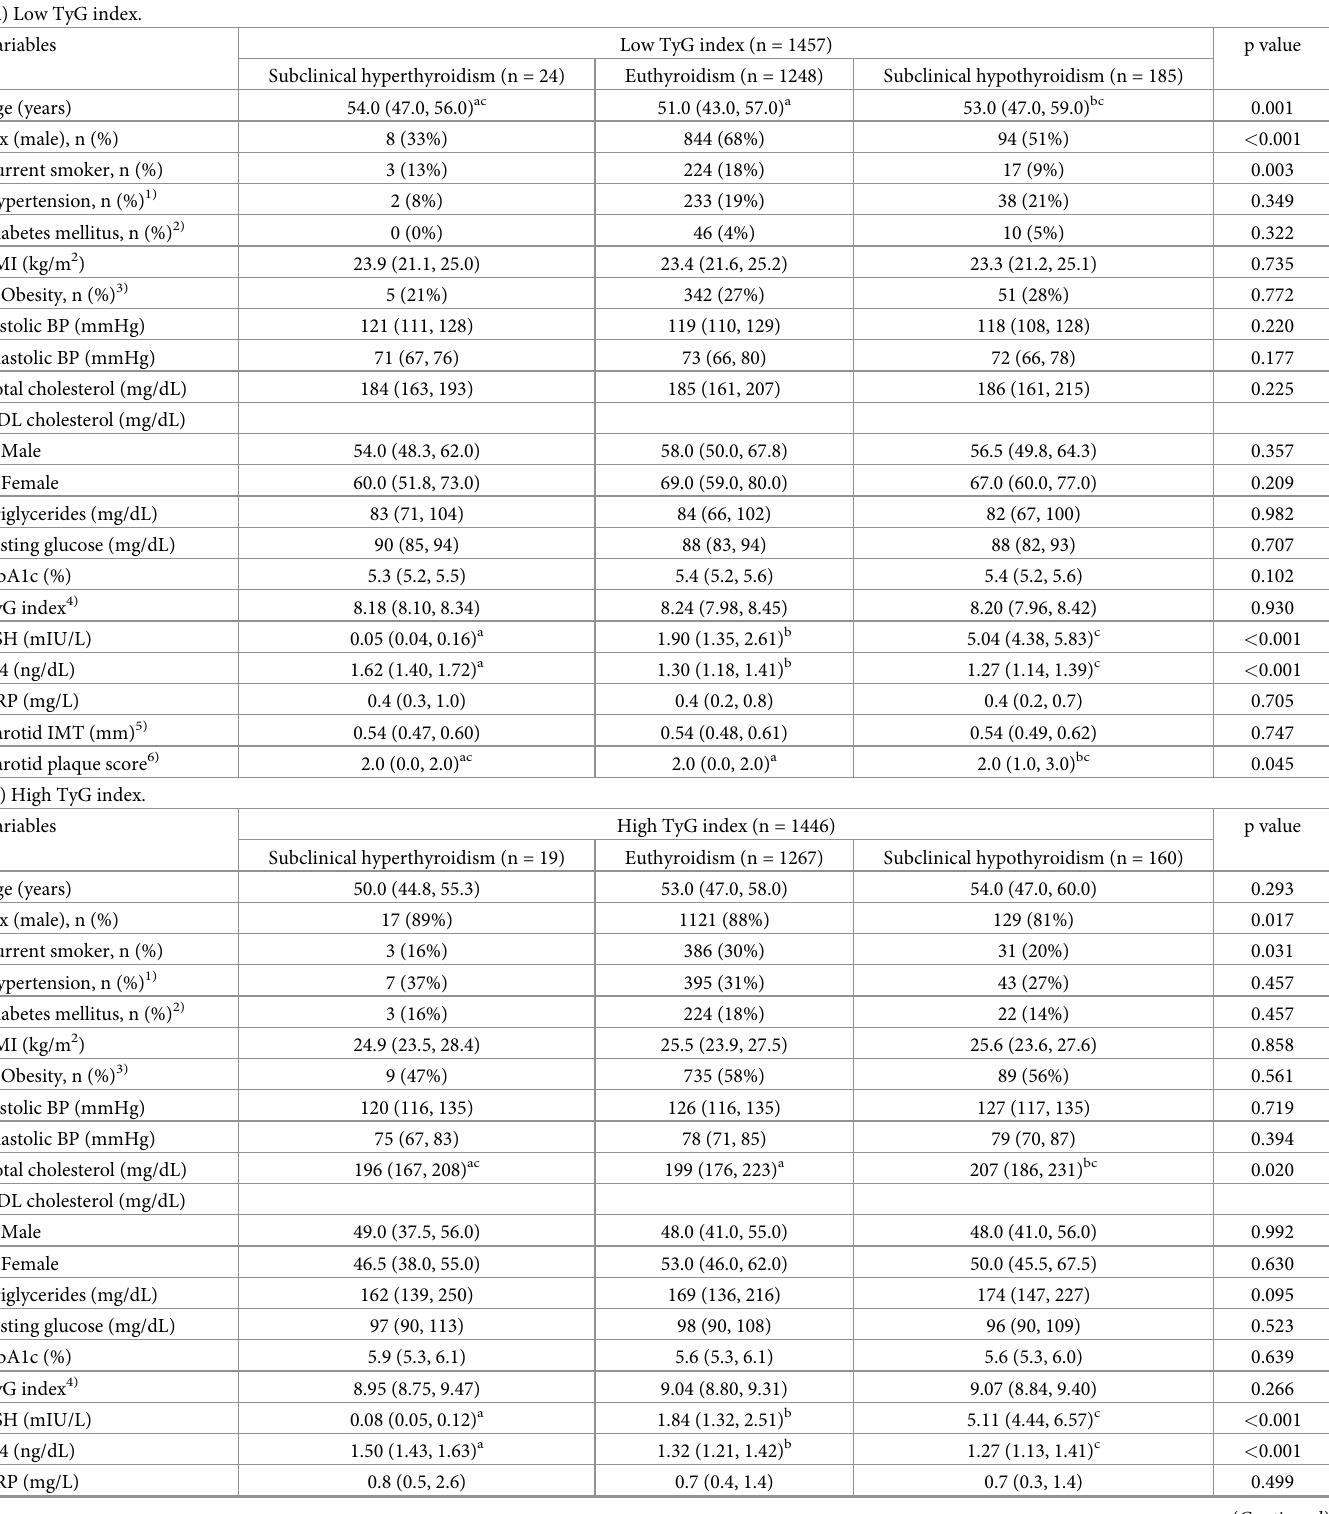
Table 2. Clinical and biochemical characteristics of participants according to thyroid function status. (A) Low TyG index.